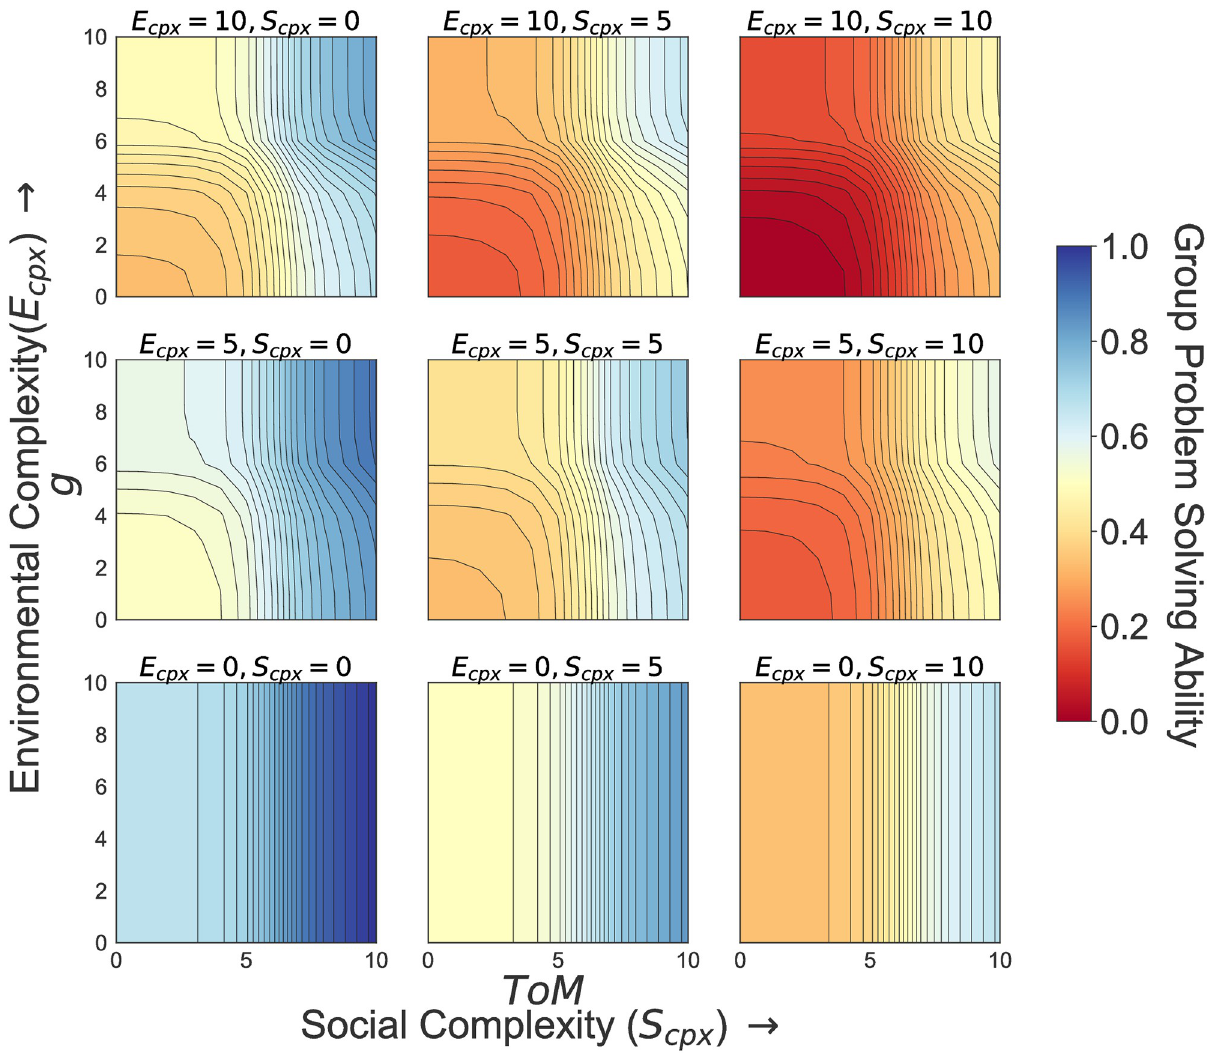
Fig 4. Effect of g and ToM for different levels of social and environmental complexity. E cpx = environmental complexity, and S cpx = social complexity averaged over α and β assuming values [1, 10]. The results depicted in Figure. 4 are all based on the following parameter range: g , ToM = [0, 10]; α and β = [1, 10] for selected values of E cpx and S cpx .